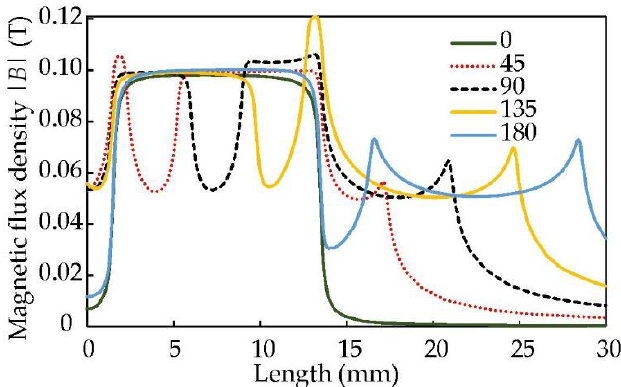
Figure 14. Magnetic flux density comparison at the angle 0 to 180 at the level of last turn between windings.